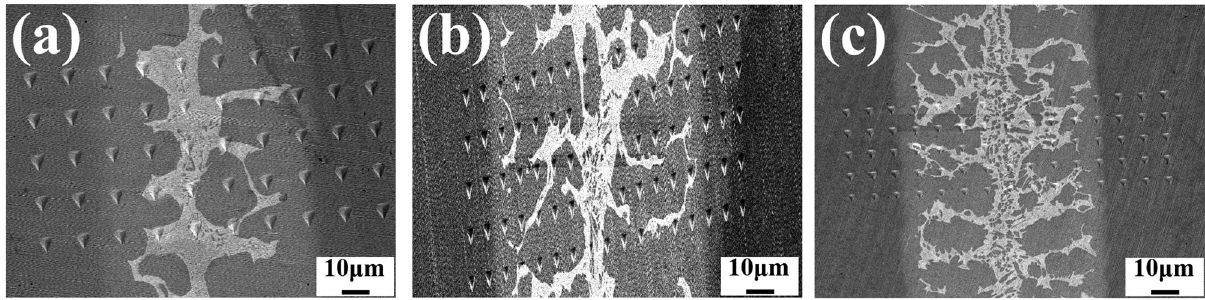
Figure 11: Distribution of hardness of the brazing seam: ( a ) 0%; ( b ) 2%; and ( c )